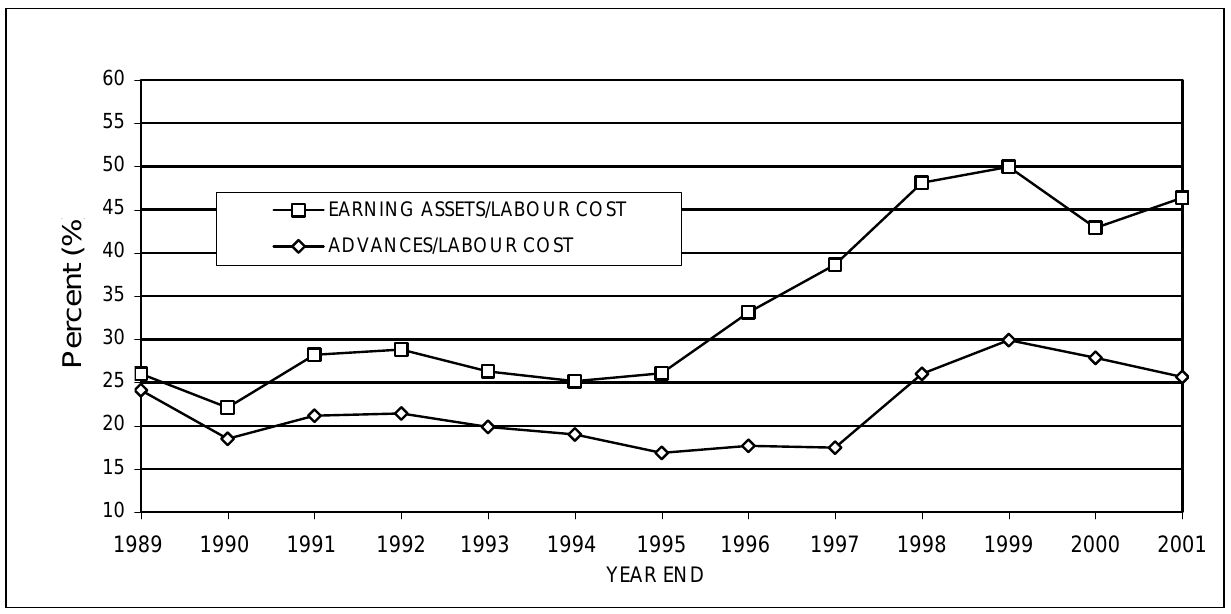
Ratio of earning assets and advances to labour costs,